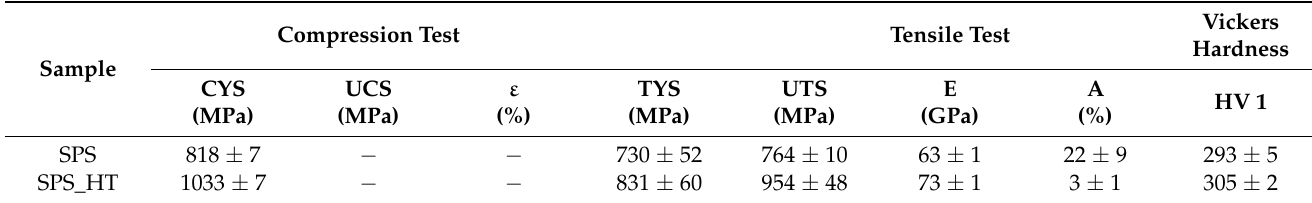
Table 2. Specific values of mechanical properties in compression and tension.